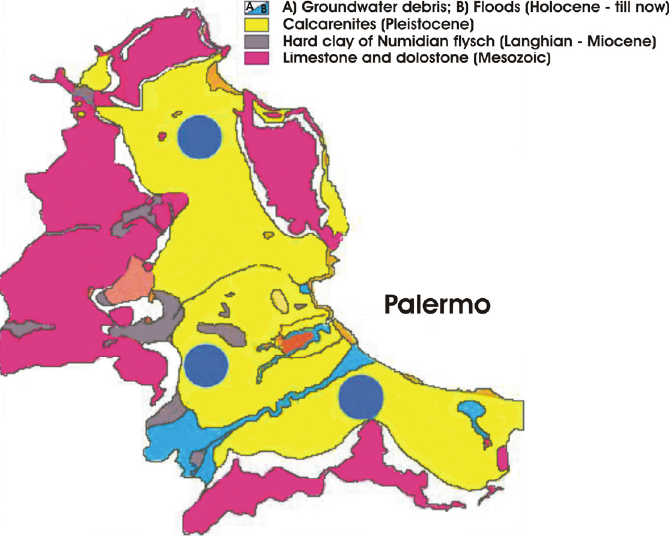
Figure 1. Geological map of the Palermo Plain. The blue circles indicate groundwater exploited in the Middle Ages: At the top, Piana dei Colli ; in the middle, Mezzomonreale ; at the bottom, Brancaccio -